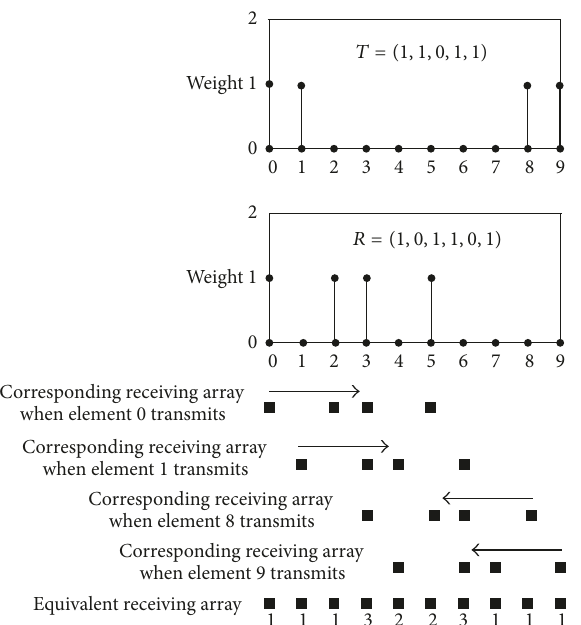
Figure 4: Equivalent array for spatial